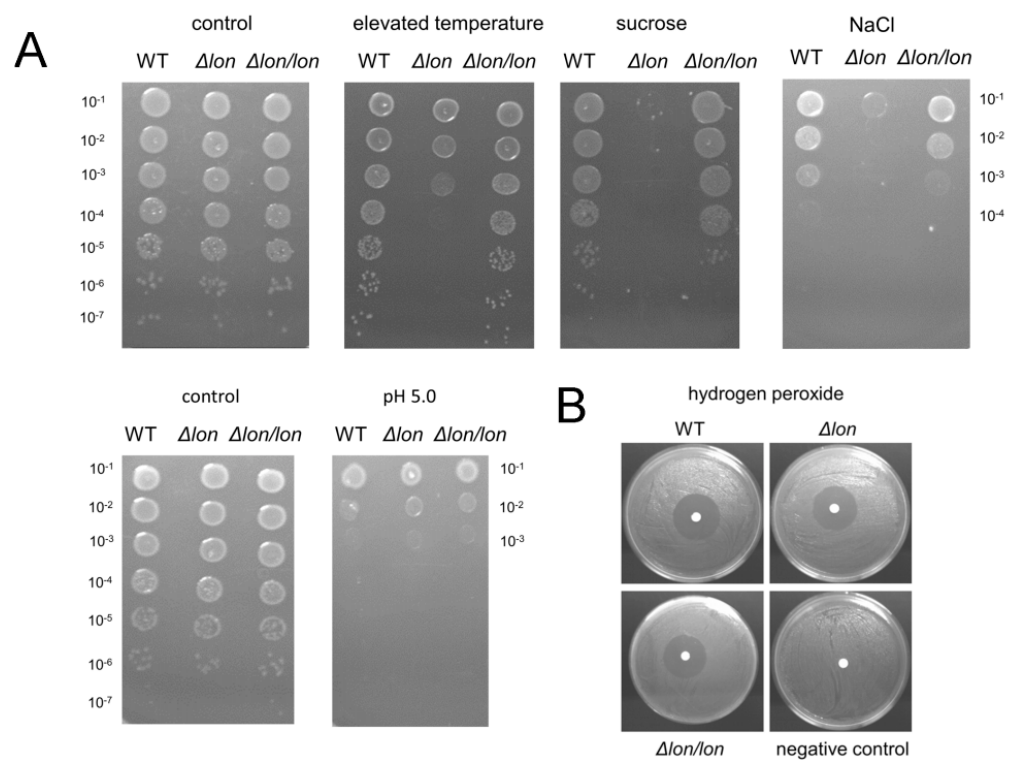
Figure 4. Growth of D. solani Δ lon under stressful conditions. ( A ) Overnight grown cultures were serially diluted and spotted on the LA (Luria Agar) agar plates, agar plates supplemented with 0.6 M sucrose or 0.3 M NaCl or on the LA medium adjusted to pH 5.0 when indicated. Bacteria grown on the LA agar plates at 30 °C refer to control. Disk diffusion assay with 1% hydrogen peroxide. As a negative control, sterile water was used ( B ). All plates were incubated at 30 °C except for the elevated temperature stress (39 °C).